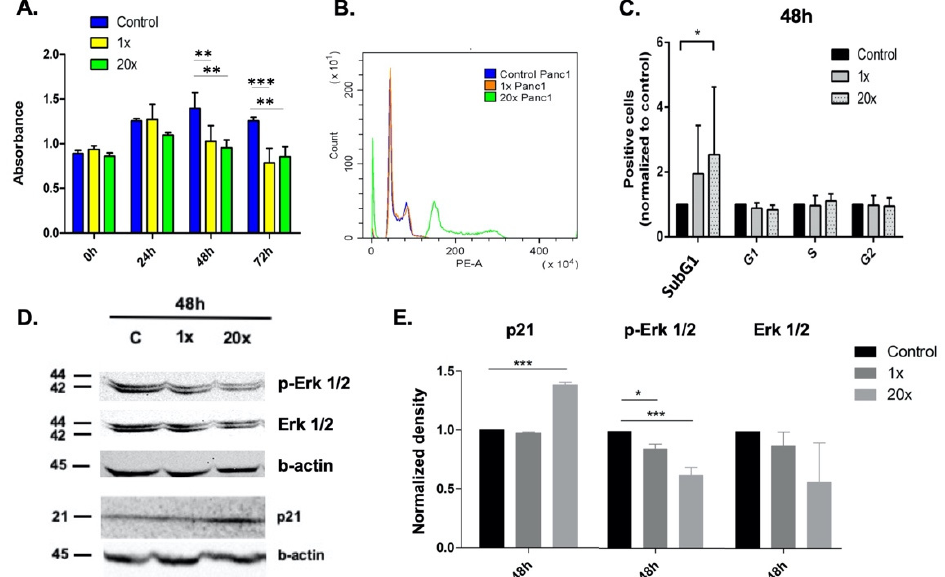
Figure 1. Proliferation and cell cycle analysis of Panc-1 cells after methyl-donor treatment. Proliferation of Panc-1 cells decreased significantly both at 48 h and 72 h after 1× and 20× methyl-donor treatments ( A ). SubG1 fraction of Panc-1 cells were significantly increased after 20× methyl-donor treatments at 48 h compared to untreated control ( B , C ). p21 (p21 WAF1/Cip1 ) growth inhibitory protein significantly increased, while p-Erk 1/2 protein level significantly decreased after both 1× and 20× methyl-donor treatments at 48 h compared to untreated control ( D , E ). Each bar represents the average number of positive cells or normalized density in cell cycle analysis or Western blot, respectively; from at least 3 repeats ± SD. Statistical significance: *: p < 0.05; **: 0.01< p < 0.05; ***: p < 0.001. 1× and 20×: concentrations of methyl donors.